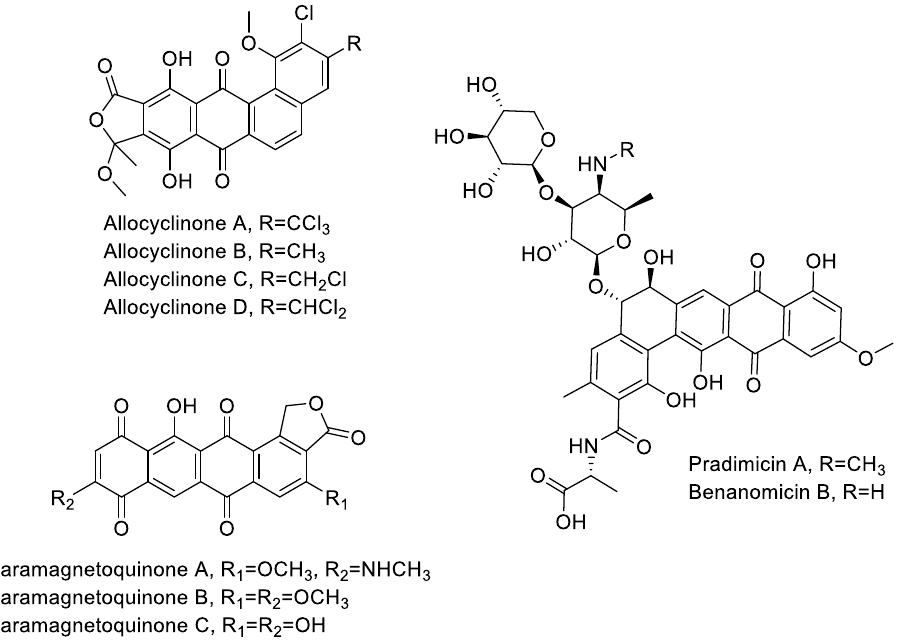
Figure 2. Chemical structures of aromatic polyketides produced by Actinoallomurus and described in Section